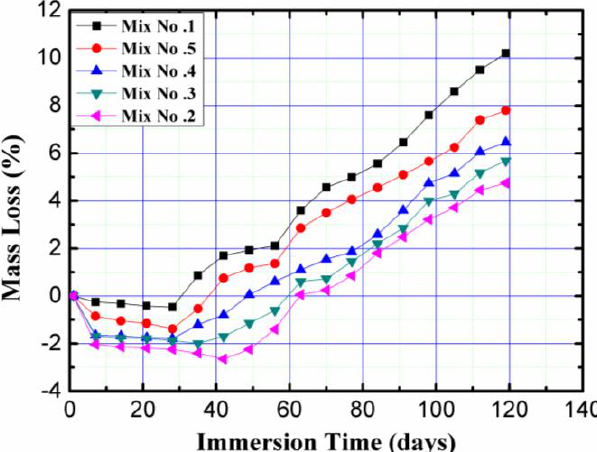
Figure 8. Percentage changes in the mass of the concrete block pavers exposed to 5% by weight of H 2 SO 4 solution with pH 1.0 versus immersion time.